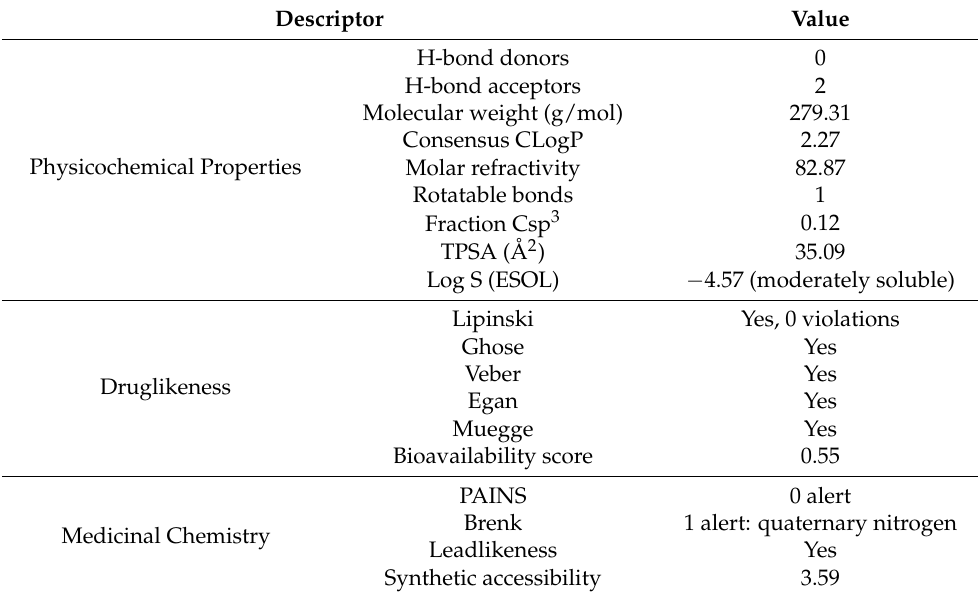
Table 3. In silico predicted physicochemical properties, druglikeness, and satisfaction of medicinal chemistry principles of the dye 12